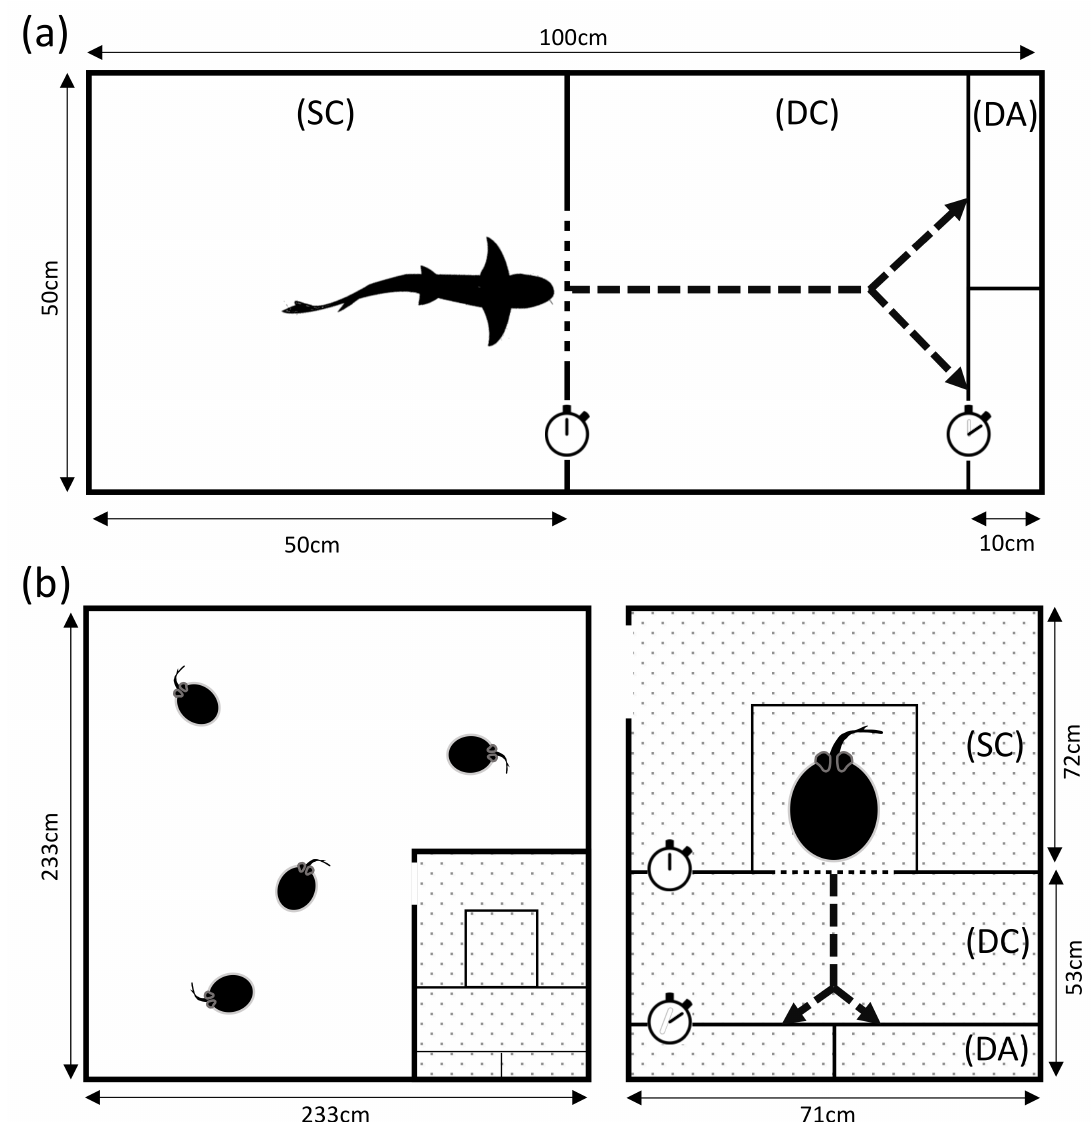
Figure 1. Overview of experimental tanks for rays and sharks. Both experimental tanks are divided into a “Starting Compartment” (SC), “Decision Compartment” (DC) and a “Decision Area” (DA). The dotted line between the SC and DC indicates the hand-operated guillotine door. Stimuli were presented on the shorter side of the experimental tank within the DA. The dotted arrows mark a simplified trial; ( a ) separate experimental tank of the sharks. ( b ) Home tank of the stingrays where the experimental tank (dotted area) was integrated which also holds a starting box for the animals within the